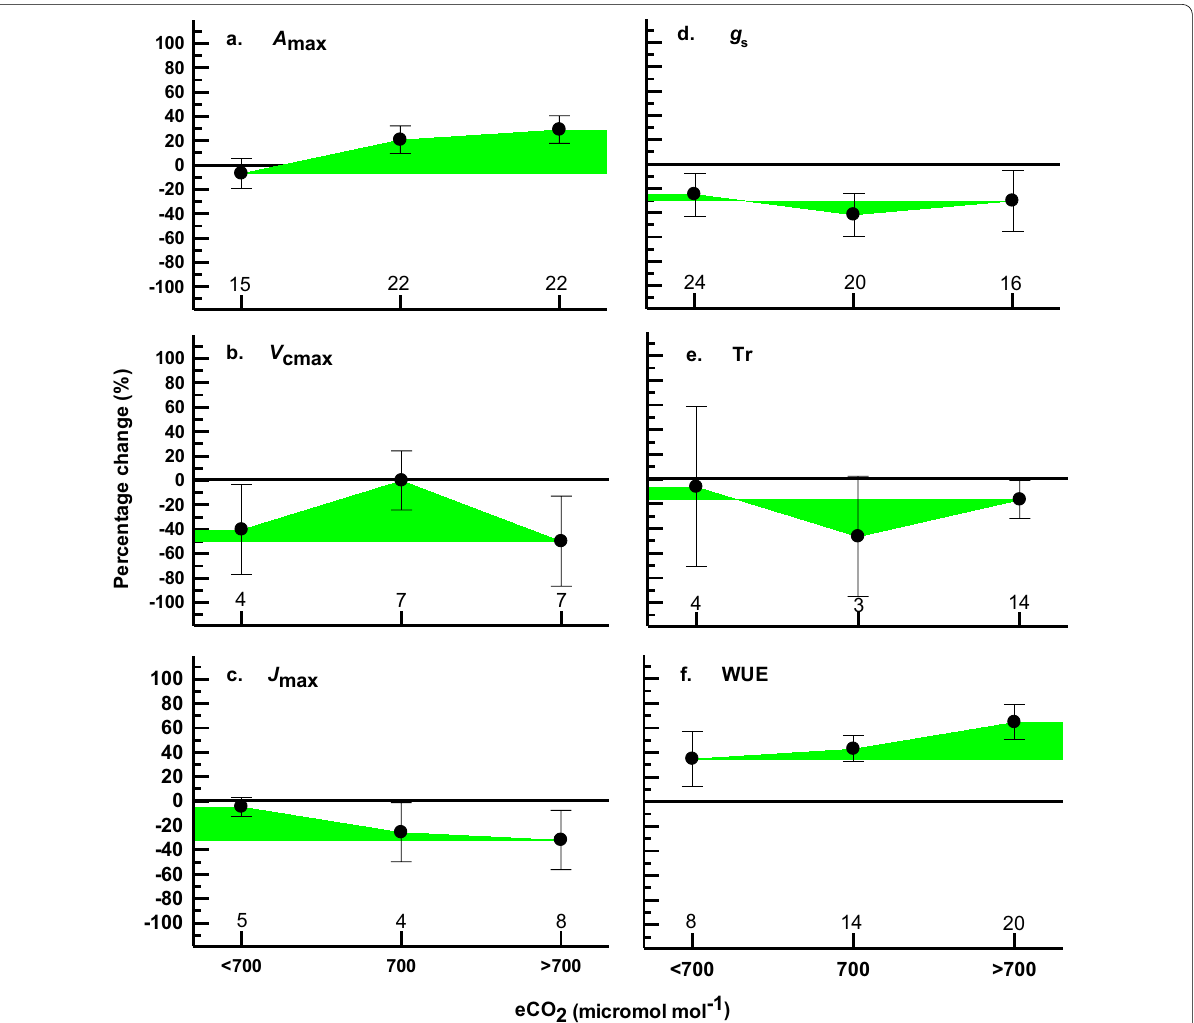
Fig. 2 Percentage change ( 95% CI) in photosynthetic characteristics ( a – c ) and water relations ( d – f ) of woody plants grown at eCO 2 . The whiskers ± denote 95% CI and the circles denote mean percentage change (MPC) between aCO 2 and eCO 2 . The numbers above the major ticks of the X -axis denote number of observations. The area fill ( ) shows the trends and the magnitude of differences between the eCO 2 concentrations. The wider the area the bigger the difference between